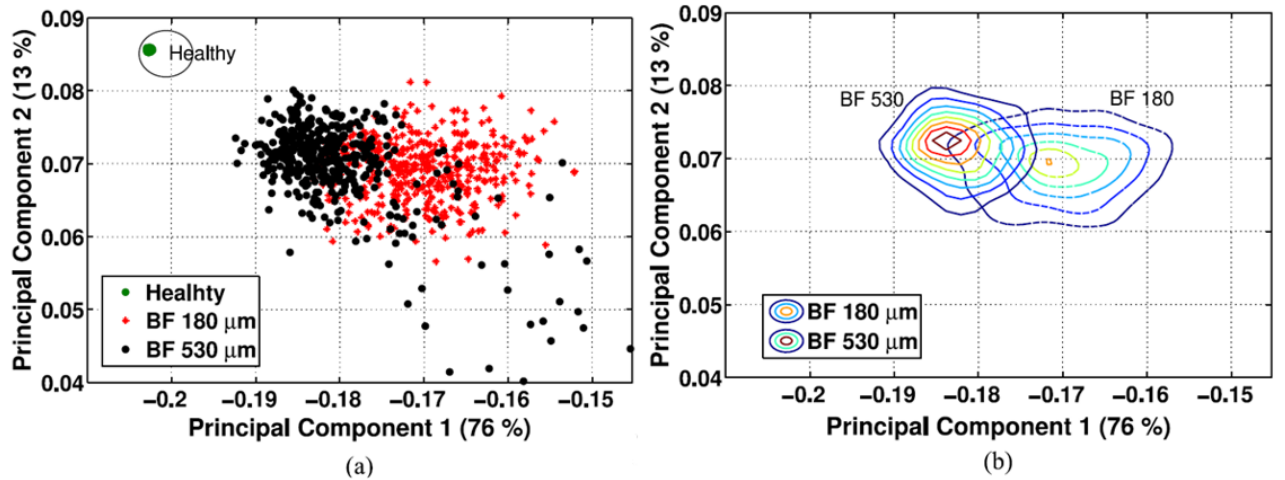
Figure 30. ( a ) Discrimination of bearing faults by PCA; ( b ) contour of PDF for estimated class of ball bearing fault [79].